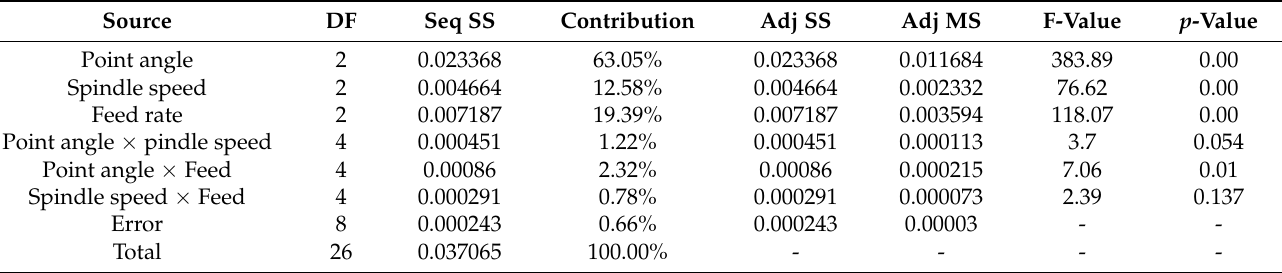
Table 5. ANOVA results of delamination factor